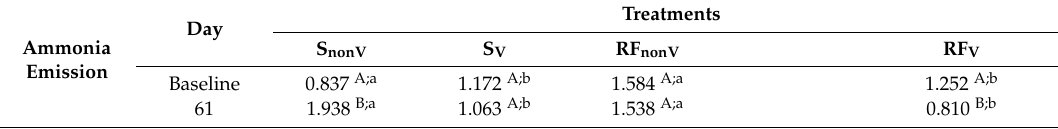
Table 6. Influence of the analysed factors on ammonia